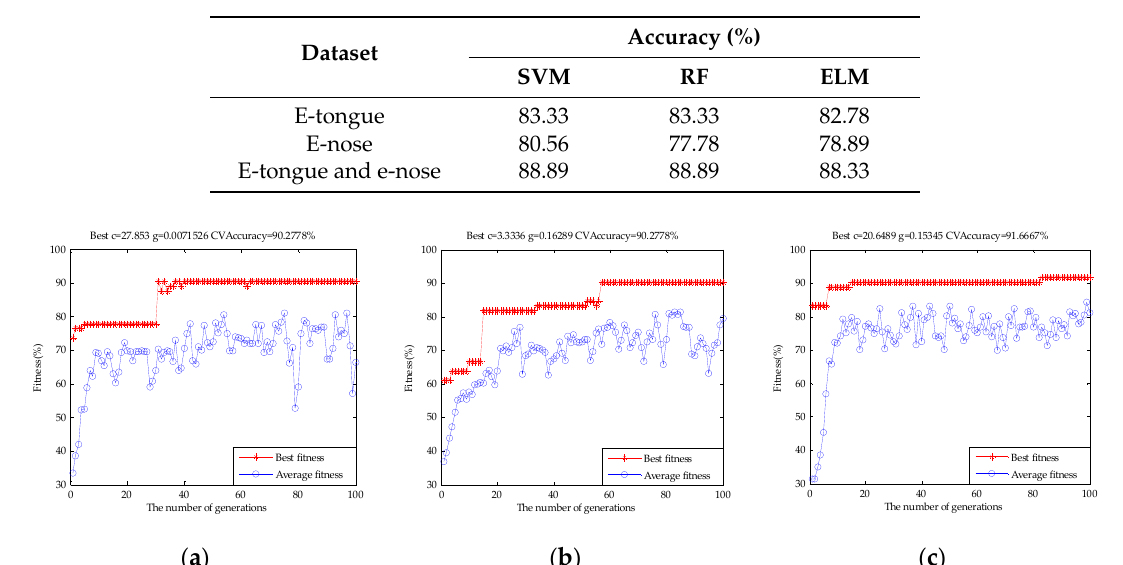
Table 2. Comparison of results for single e-tongue, e-nose, and the original fusion set.